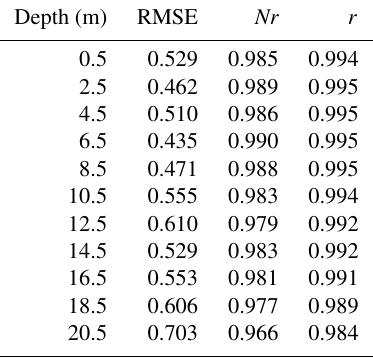
Table 2. Statistical results (RMSE, Nr , and r value) between sim- ulations and observations of water temperature at different depths from 0.5 to 20.5m at intervals of 2m. The sample number is 436 for the bottom layer (depth 20.5m) and 510 for all other